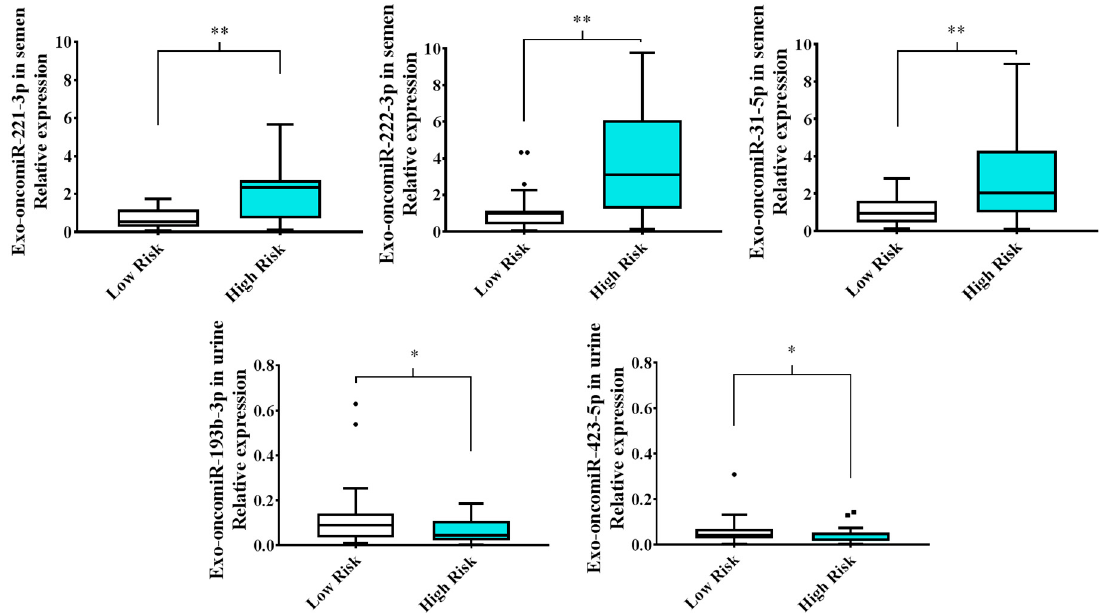
Figure 2. Exo-oncomiRNAs are differentially expressed in liquid biopsy from patients with prostate cancer. Box plots of relative expression of the 5 discriminatory exo-oncomiRNAs analyzed in semen and post-digital rectal examination urine liquid biopsies from patients with low- and high-risk PCa. Results are expressed as mean values ± SD. Statistical differences between groups are indicated: * p < 0.05; ** p < 0.01. Table 2. Anthropometric and analytical characteristics according to ISUP-GG criteria.